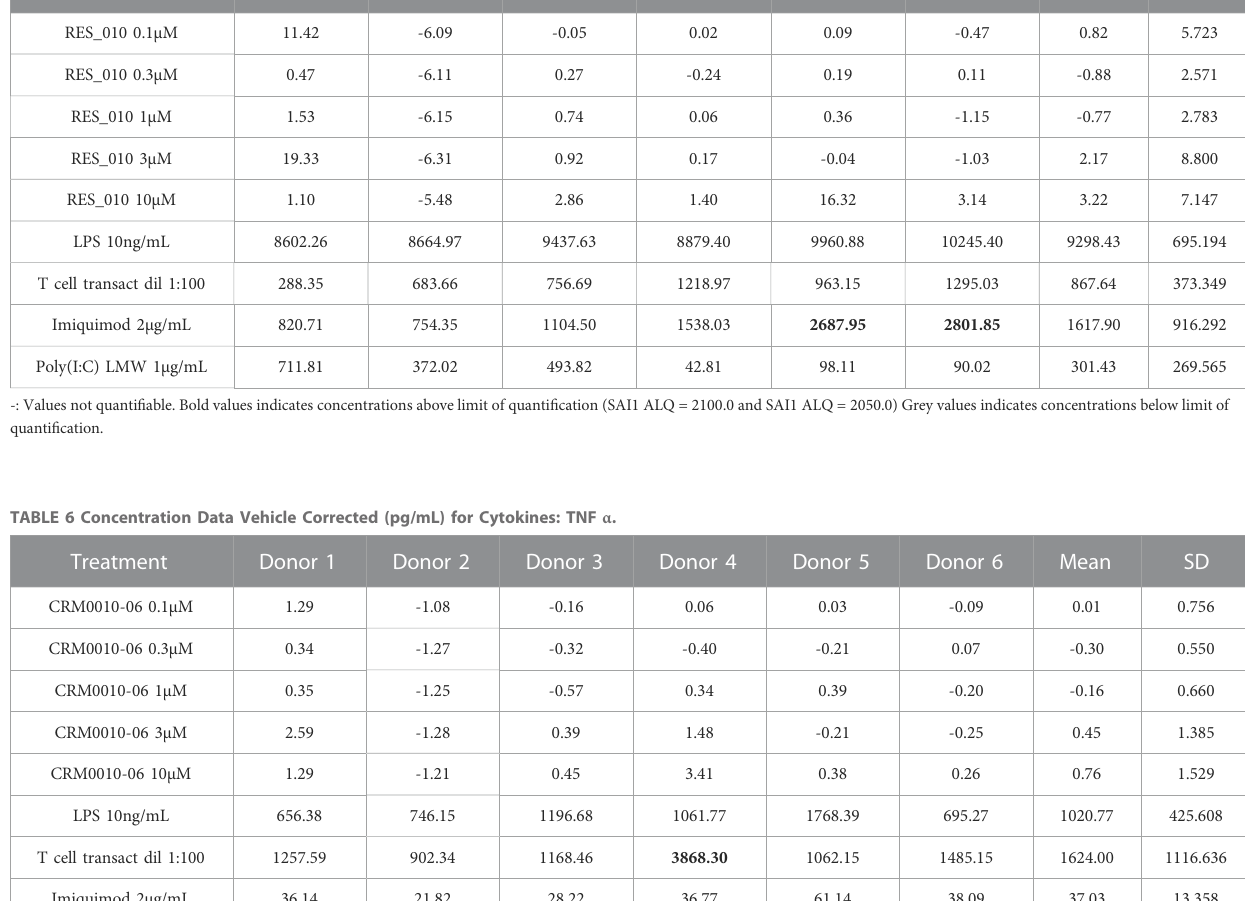
TABLE 5 Concentration Data Vehicle Corrected (pg/mL) for Cytokines: IL-6. Treatment Donor 1